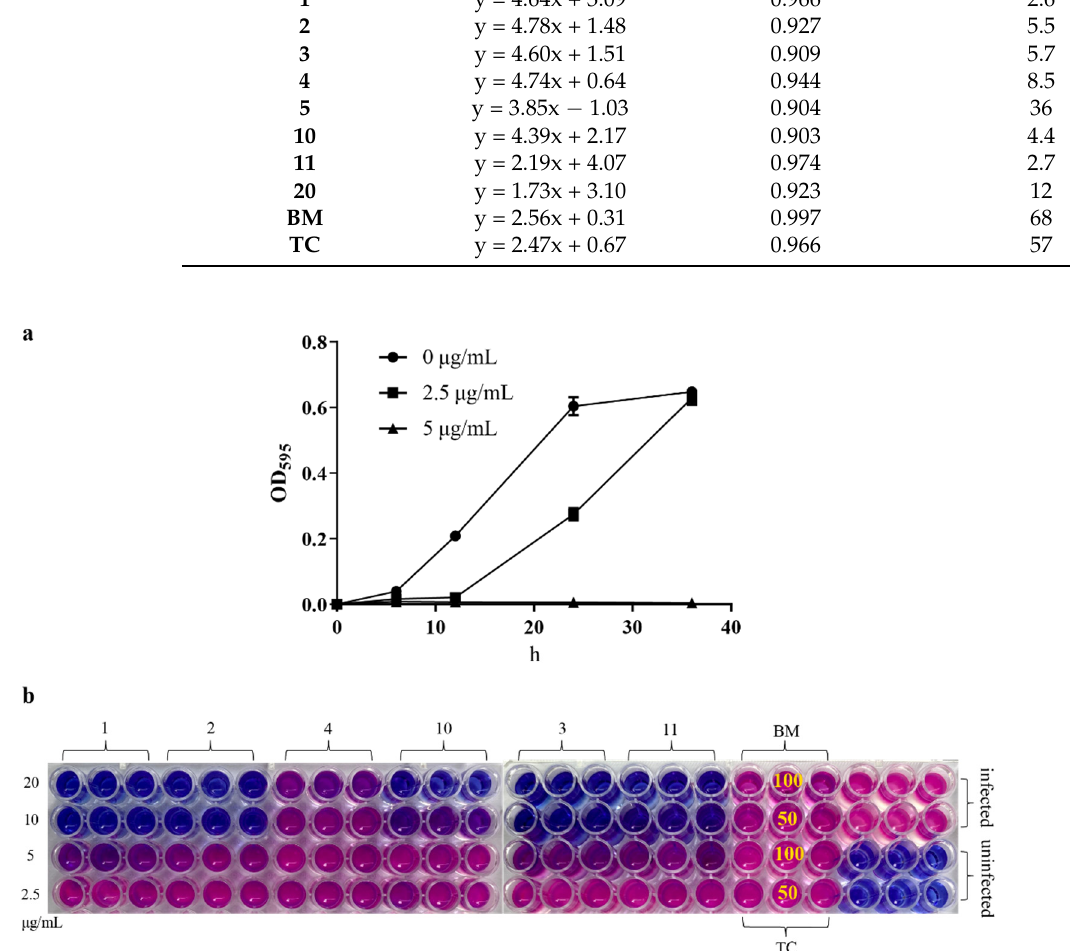
Figure 1 . ( a ) The growth curve of Xac under the action of compound 1; the test concentrations were 5.0 and 2.5 μ g/mL, and the absorbance was measured at 595 nm at 0, 6, 12, 24 and 36 h, respectively. ( b ) Resazurin blue assay, the test concentrations of target compound were 20, 10, 5.0, and 2.5 μ g/mL, and the test concentrations of BM and TC were 100 and 50 μ g/mL for the compound-treated groups. Pink indicates bacterial growth and blue means no bacterial growth (the corresponding concentration is the MIC value).